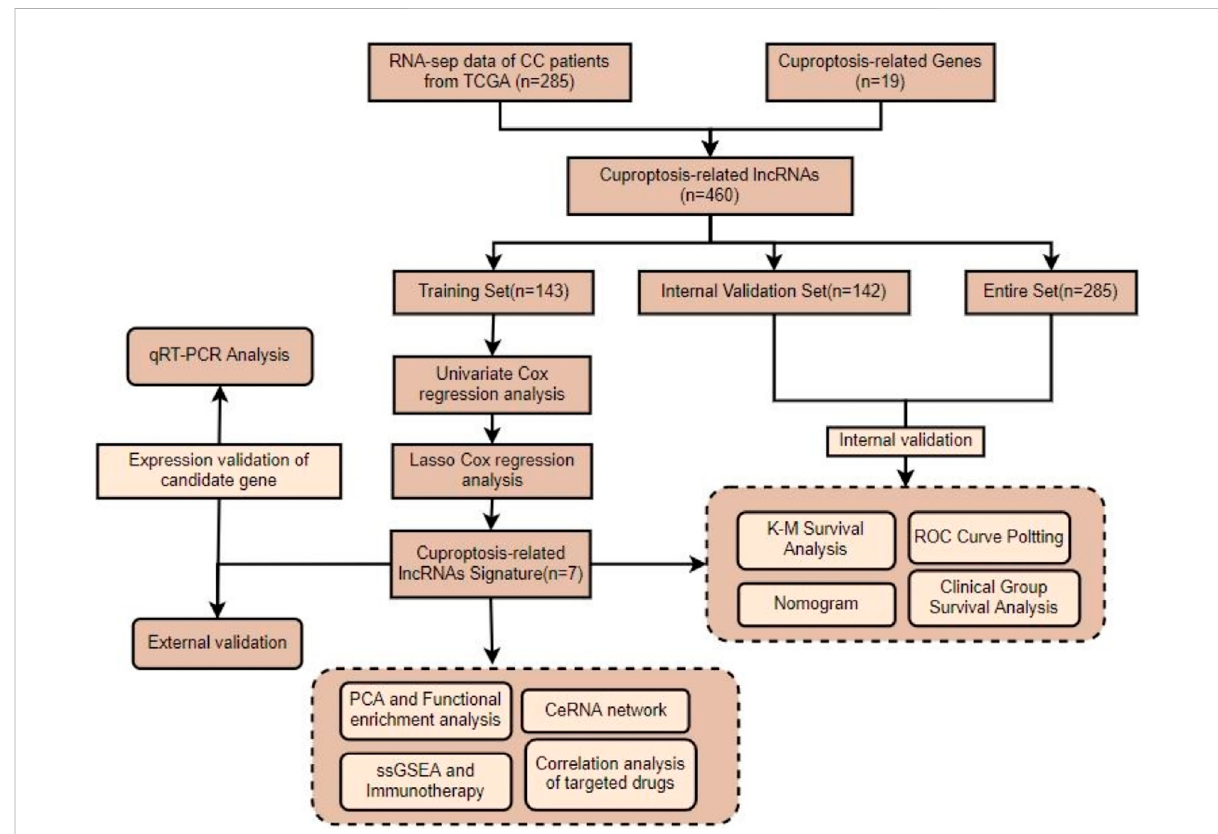
FIGURE 1 Flow chart showing the scheme of our study on cuproptosis-related lncRNAs in